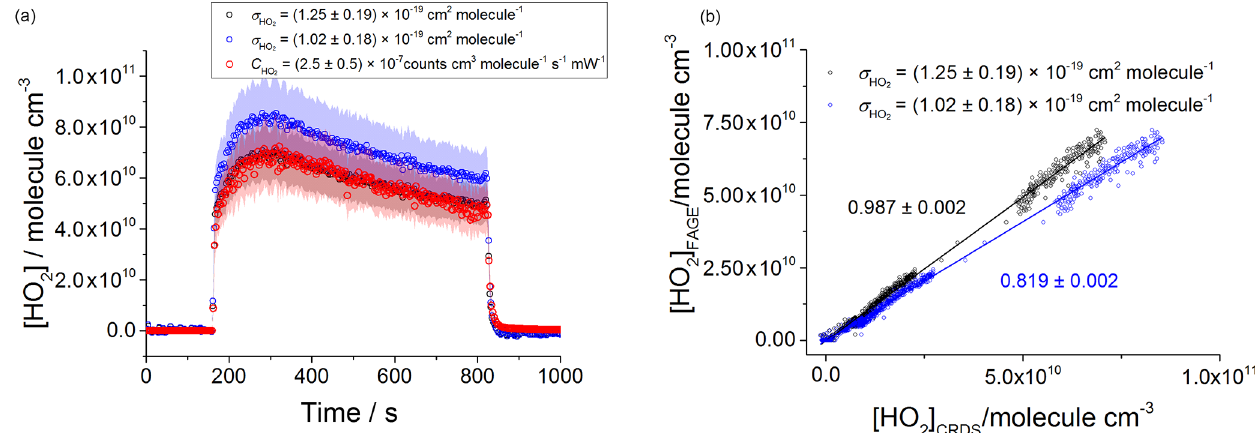
Figure 8. (a) Comparison HO 2 measurement at 150mbar where the lamps were switched on at t =∼ 150s for ∼ 10min. HO 2 measured by FAGE ( C 150mbar = 2.6 × 10 − 7 countscm 3 molecule − 1 s − 1 mW − 1 , red) is plotted with HO 2 measured by CRDS using = 1.25 × 10 − 19 cm 2 molecule − 1 obtained (Sect. 3.2) by application of pressure broadening to the spectral lines found by Thiebaud σ HO 2 = 1.02 × 10 − 19 cm 2 molecule − 1 determined using the kinetic decays of HO et al. (2017) (black), and σ HO 2 in Sect. 3.3.1 (blue). Each 2 data point is an averaged value over 3s. [CH 3 OH] = 6.6 × 10 13 moleculecm − 3 , [Cl 2 ] = 4.4 × 10 13 moleculecm − 3 . (b) Correlation plot at = 1.25 × 10 − 19 cm 2 molecule − 1 determined in Sect. 3.2 (black) and 150mbar for data plotted in (a) . [HO 2 ] CRDS was calculated using σ HO 2 = 1.02 × 10 − 19 cm 2 molecule − 1 determined in Sect. 3.3.1 (blue). The gradients of linear unweighted fits of the data are 0.987 ± 0.002 σ HO 2 (black) and 0.819 ± 0.002 (blue). Both lines intercept the y axis at ( − 1.0 ± 0.5) × 10 8 moleculecm − 3 . [HO 2 ] FAGE was calculated using a sensitivity factor of 2.6 × 10 − 7 countscm 3 molecule − 1 s − 1 mW − 1 from the HO 2 decay as discussed in Sect. 2.3.2. Each data point is an averaged value over